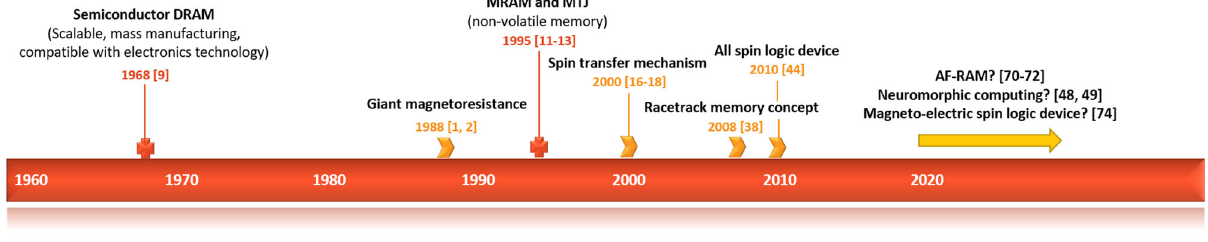
Fig. 6 Timeline of major research and technology milestones in data storage devices. We present a synthesis of major achievements towards non- volatile energy-ef fi cient storage devices. Cross symbols indicate a commercialise technology and chevron arrows indicate a research